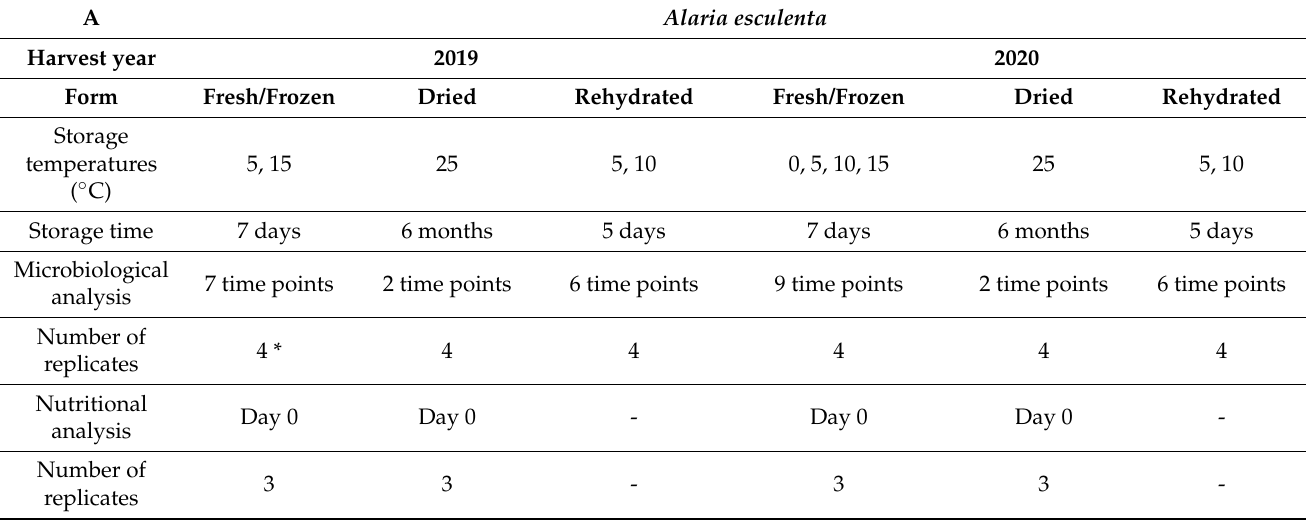
Table 1. Brief description of the experimental design. Alaria